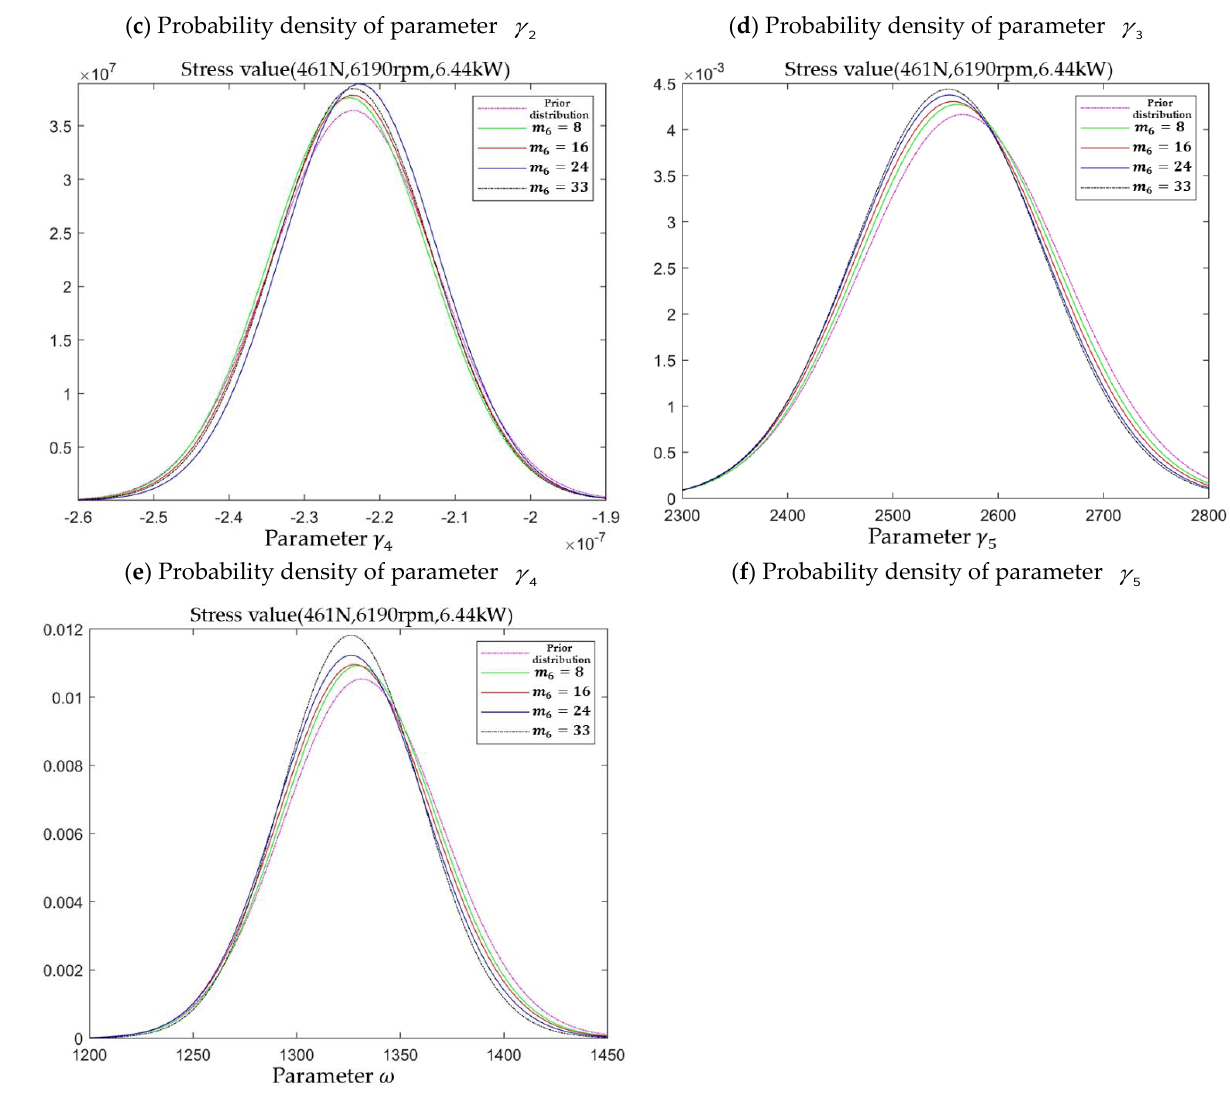
Figure 8. The update process of probability density of each model parameter with the test ( l = 6) At the end of the test for stress level l = 6, IG = 101.248 > EIG = 35.4401, which satisfies